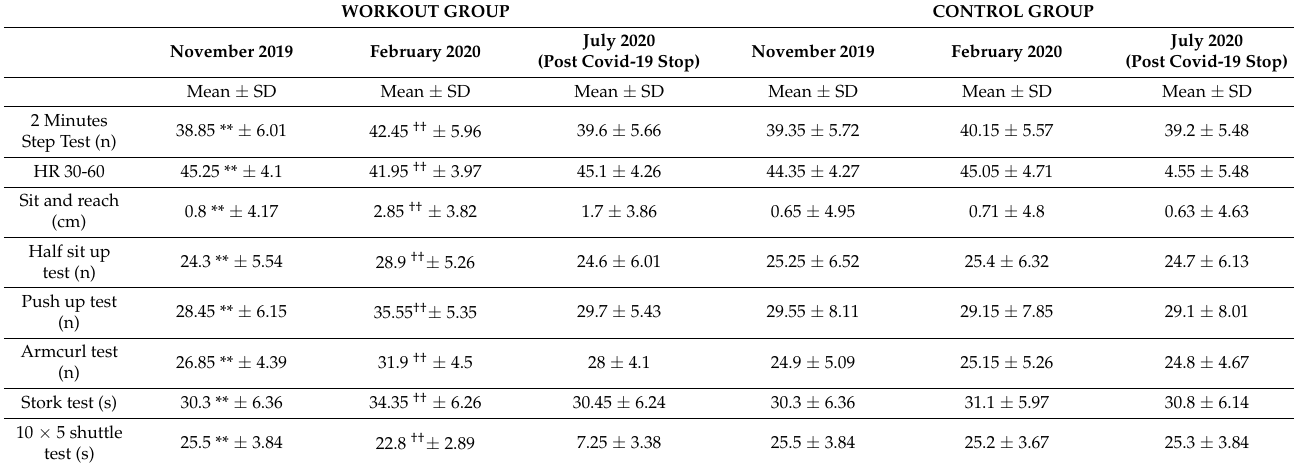
Table 2. Pre and post values for fitness level variables of workout group and control group shown as mean ± DS. WORKOUT